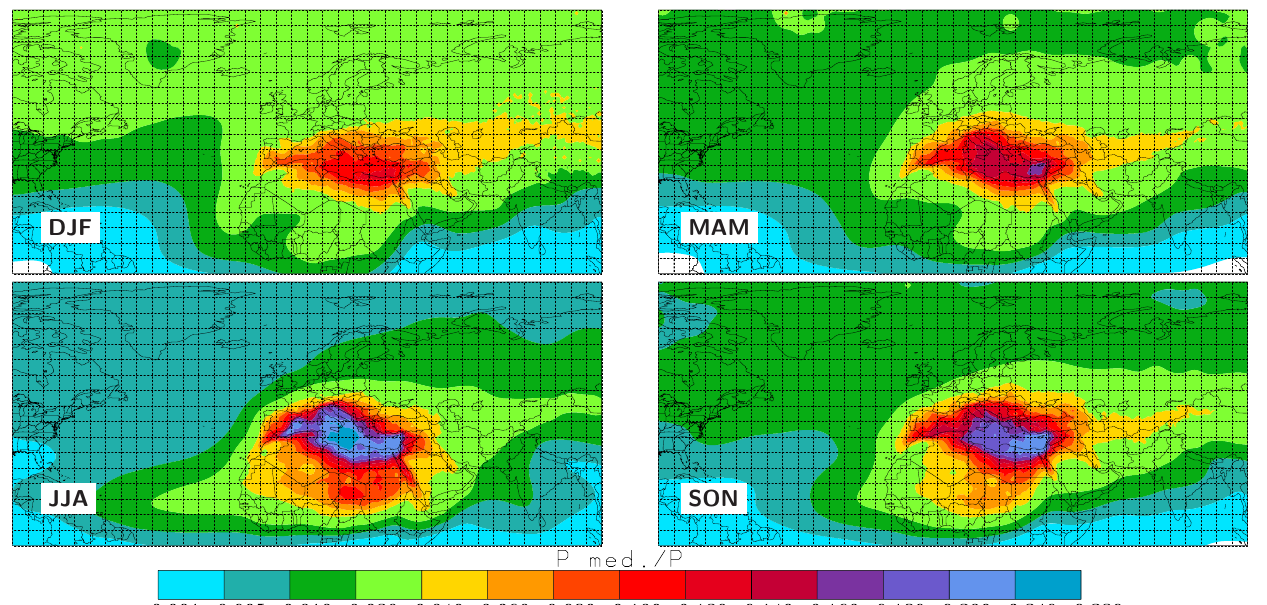
Fig. 12. Fraction of precipitated water that evaporated inside the Mediterranean basin.